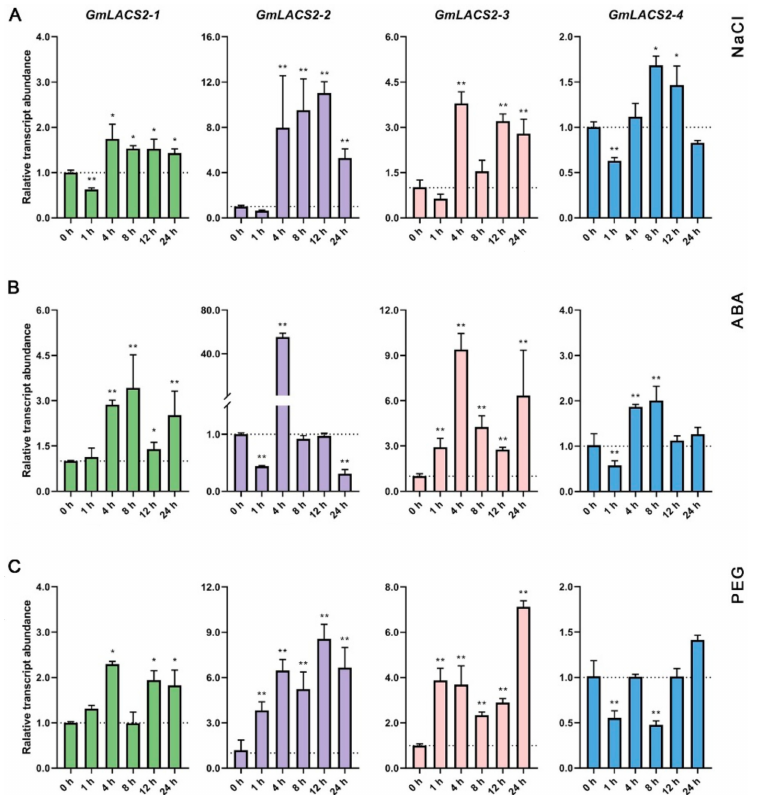
Figure 3. The expression profile of different GmLACS2 transcripts under NaCl ( A ) ABA. ( B ) PEG. ( C ) treatments at different time intervals. * and ** respectively indicate significant difference ( p < 0.05) and highly significant difference ( p < 0.01).